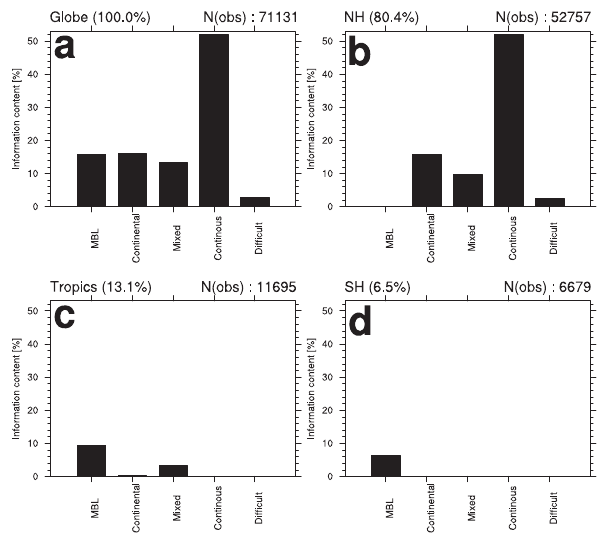
Figure 10. Histograms of the average information content for each observation site category (a) around the globe and in the (b) North- ern Hemisphere, (c) tropics, and (d) Southern Hemisphere from 2001 to 2009. N (obs) in the upper right corner represents the num- ber of observations used in data